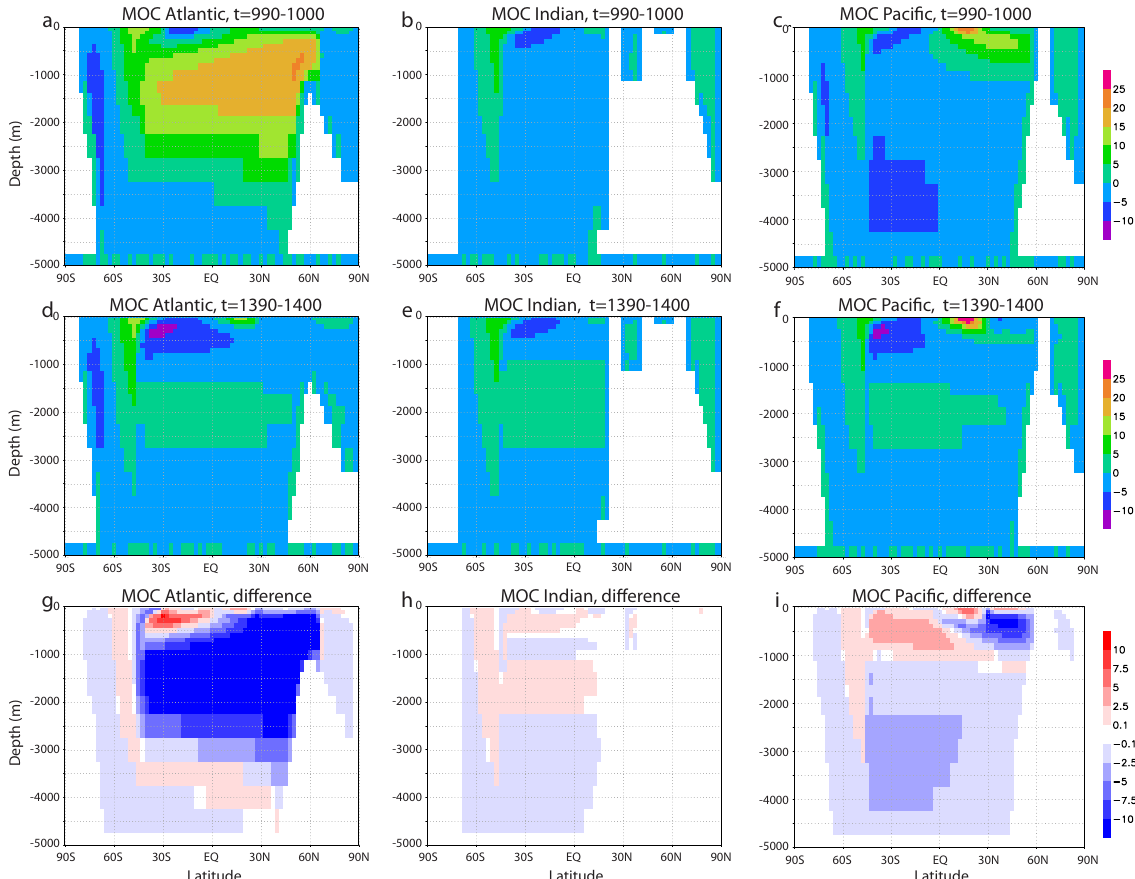
Fig. 5. Meridional overturning streamfunction (Sv) for the simulation during the Preindustrial with a fresh water flux added into the North Atlantic of 0.5Sv during 400 yr at (a, b, c) the average of years990–1000, (d, e, f) the average of years1390–1400 and (g, h, i) the difference between the two for the three basins: (a, d, g) Atlantic, (b, e, h) Indian and (c, f, i)